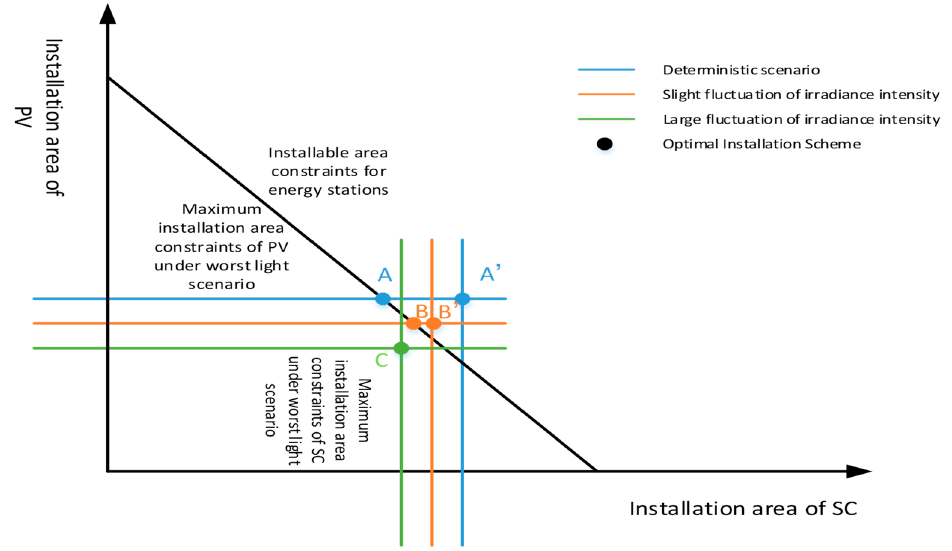
Figure 4. Analysis of the accommodation capacity under different irradiance fluctuation ranges.